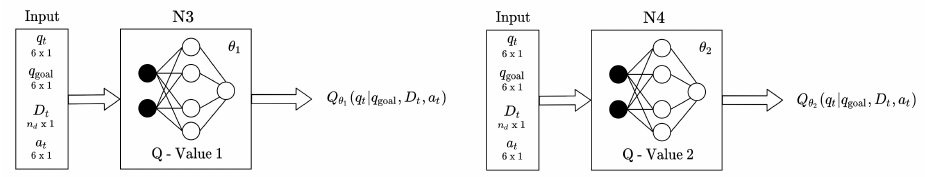
Figure 4. The deep neural network for the action value function